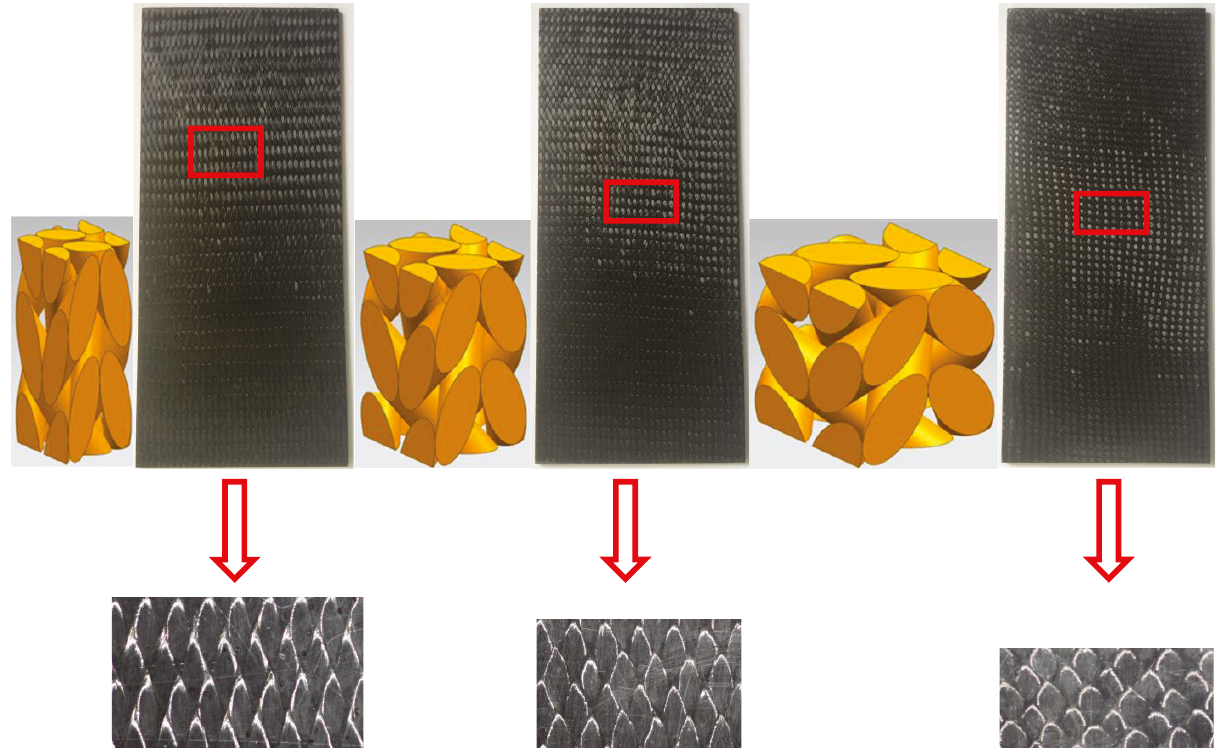
Figure 3: 3D braided composite specimen with di ff erent braiding angles.